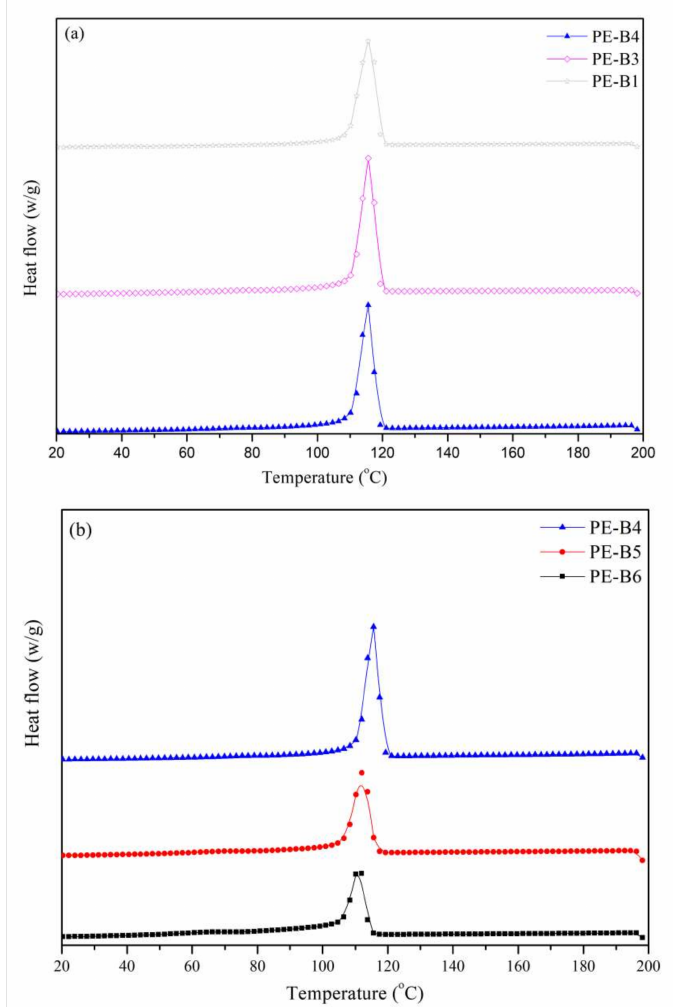
Figure 4. DSC Crystallization curves of samples ( a ) PE-B1, PE-B3, PE-B4; ( b ) PE-B4, PE-B5, PE-B6. The foam expansion ratio was calculated based on the following equation: VER = ρ / ρ f. Herein, ρ and ρ f represent the density of polyethylene blends before and after foaming. Density was measured by weighing each sample with a precision of 0.0001 mg and calcu- lating its volume as the volume of water displaced in a calibrated pycnometer where the sample was submerged. To determine the cell size (CS) and cell diameter distribution (CSD), a micrograph of each sample was taken using an optical microscope. The cell diameter distribution (CSD) was also obtained by measuring and counting the observed bubbles. All cells morphology of foamed parts is showed in Figure